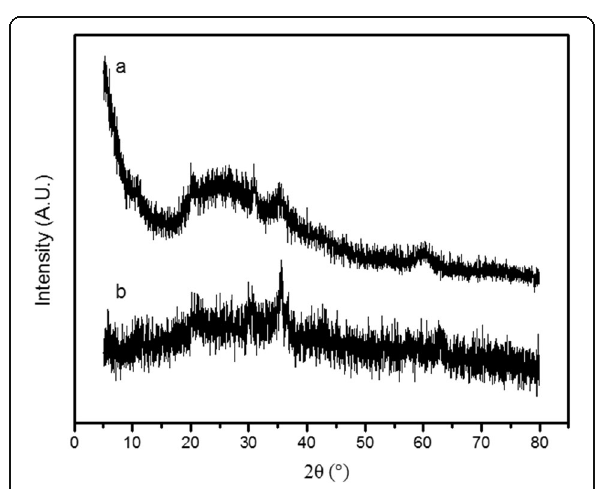
Fig. 3 XRD pattern of ( a ) ASN and ( b ) ASN-MPs